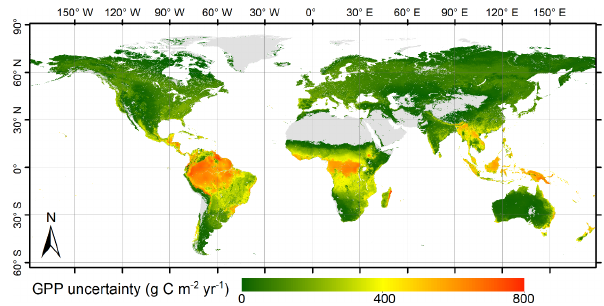
Figure 7. Spatial pattern of the uncertainty in global GPP simulated by the revised EC-LUE